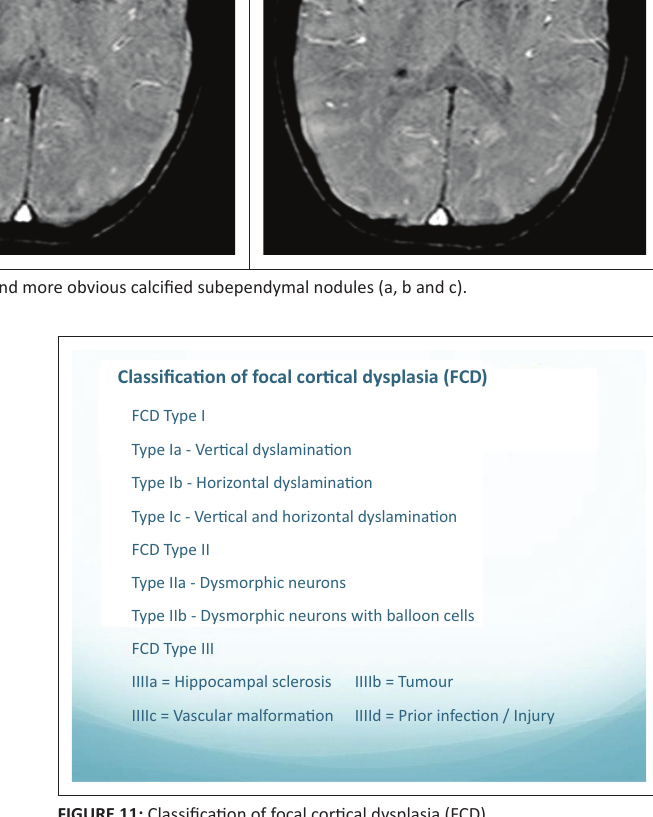
FIGURE 11: Classification of focal cortical dysplasia